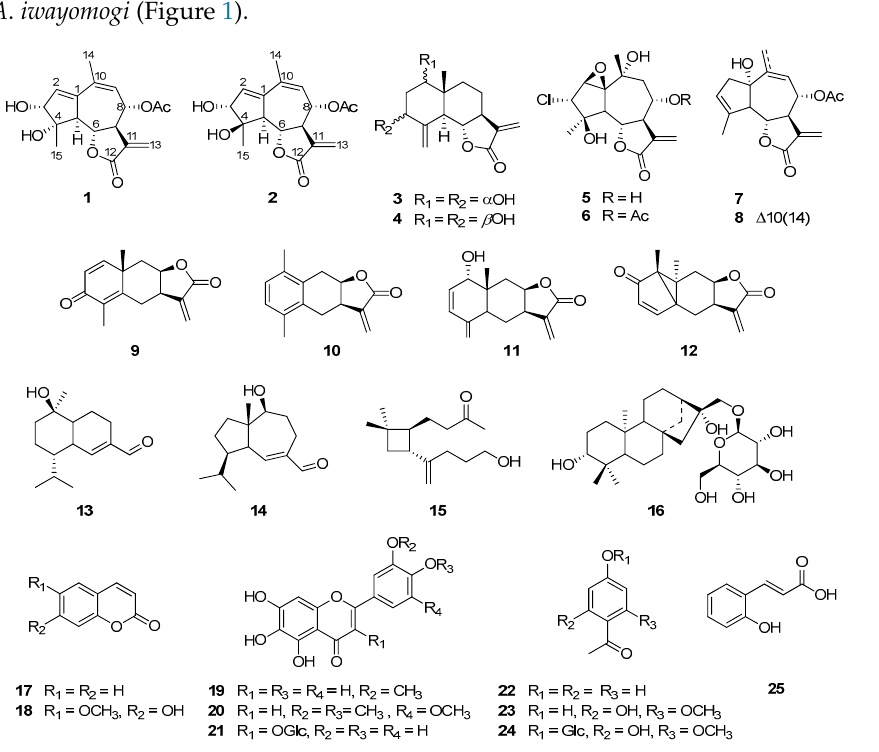
Figure 1. Chemical structures of compounds 1 – 25 isolated from the aerial parts of A . iwayomogi .